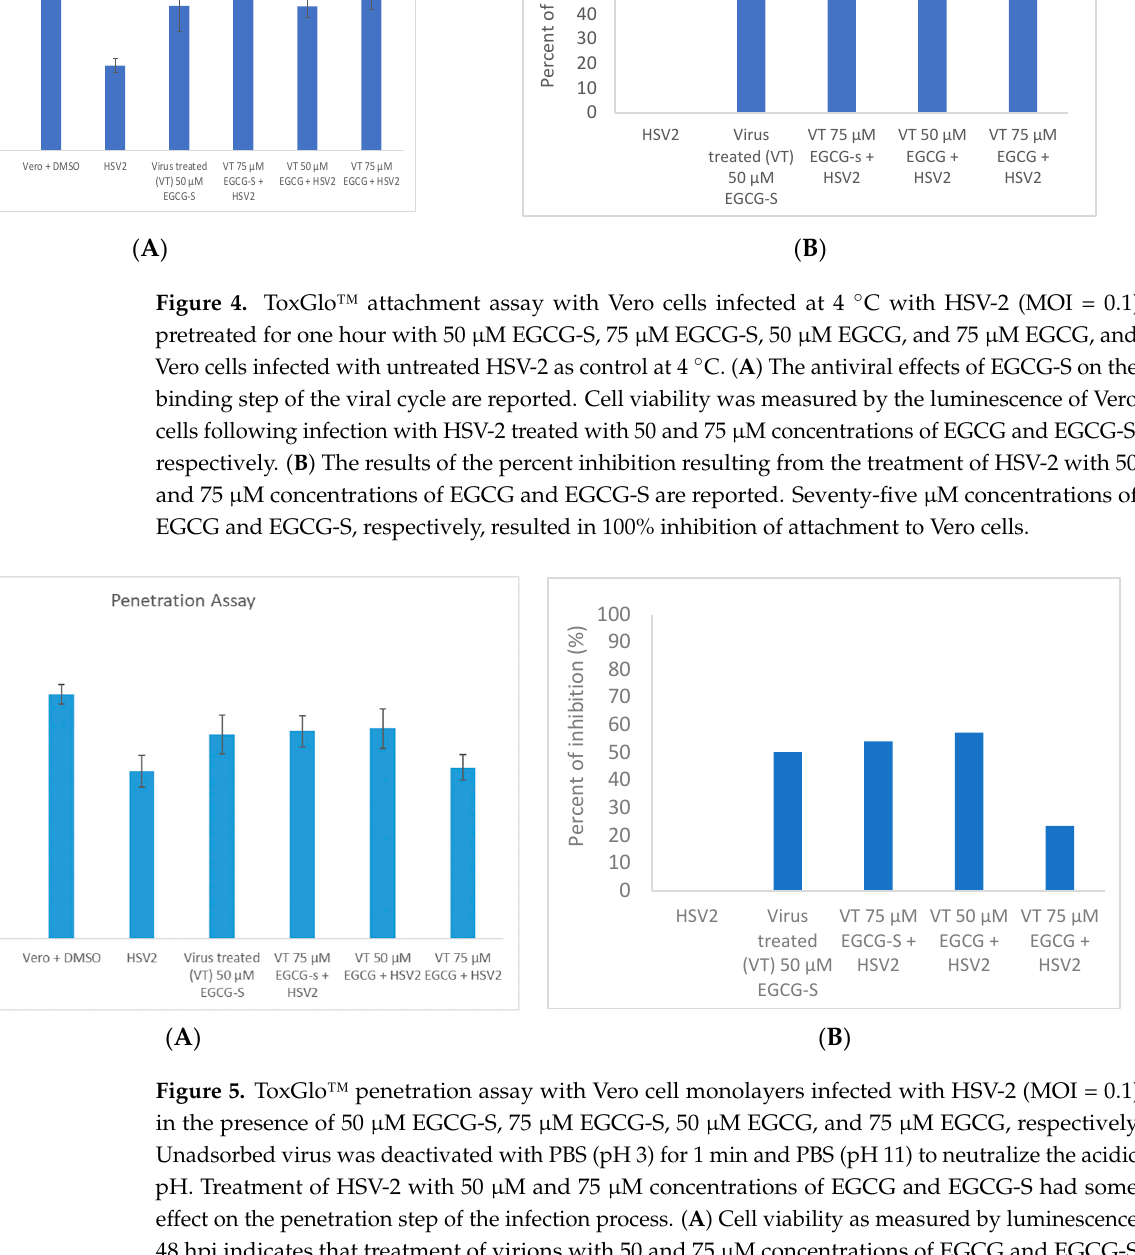
Virus treated (VT)